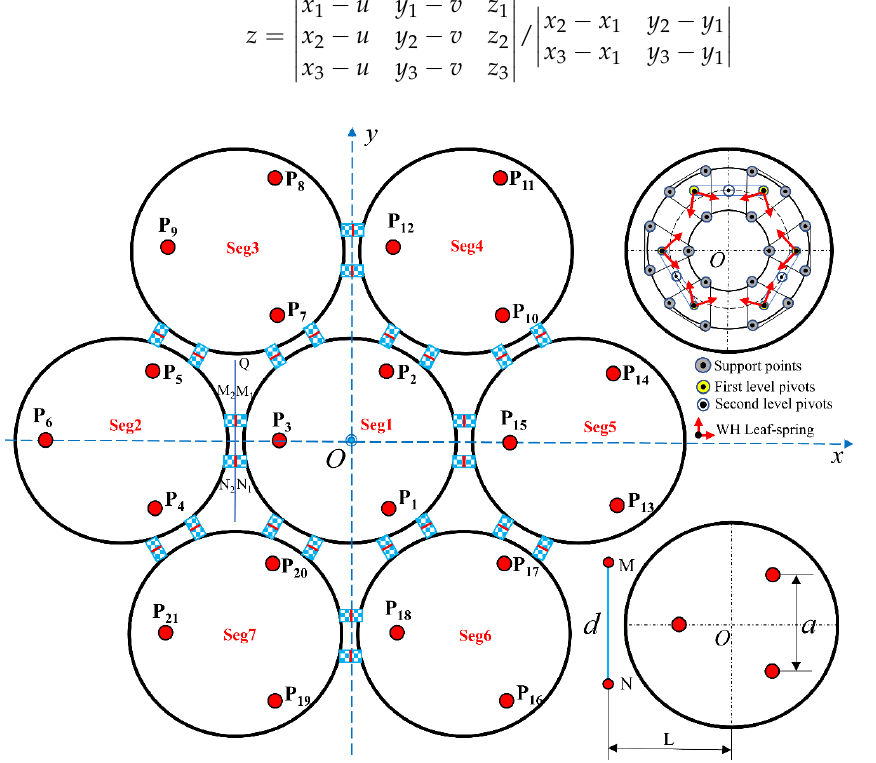
Figure 1. Schematic diagram of the segment arrangement.